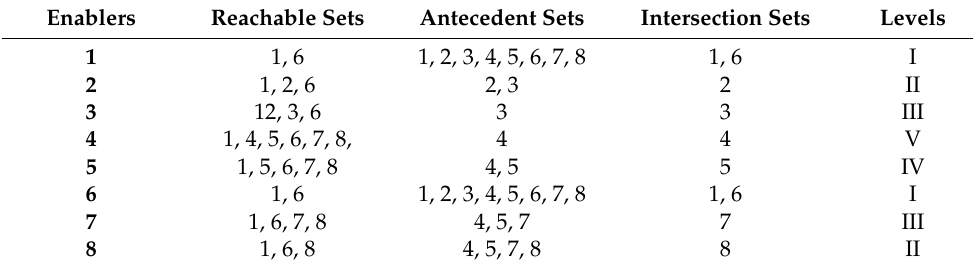
Table 3. Combined Levels of the Enablers.